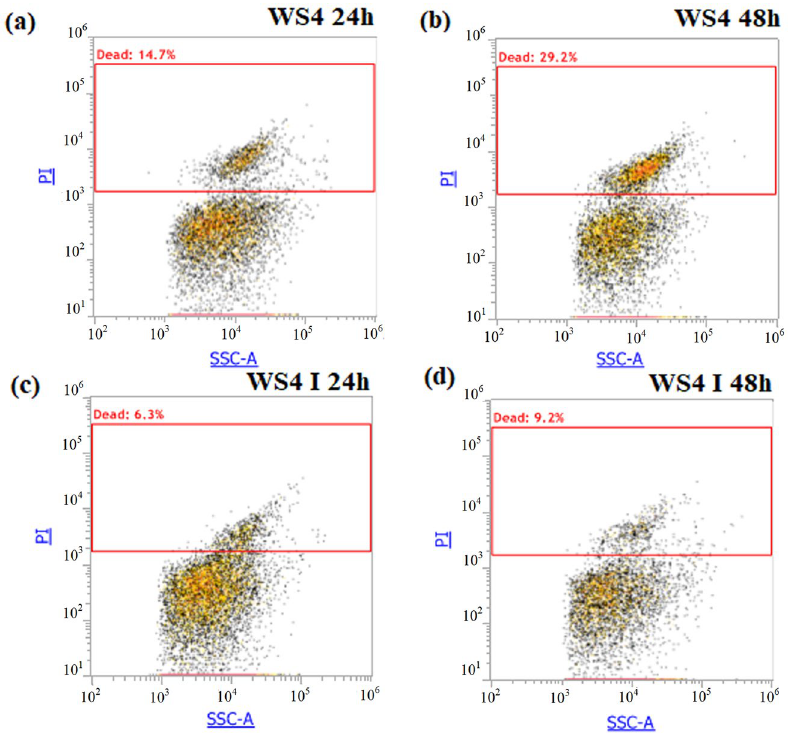
Figure 3. PI single stained dot plots of P. temperata: (a) WS4 at 24 h; (b) WS4 at 48 h; (c) WS4 I at 24 h and (d) WS4 I at 48